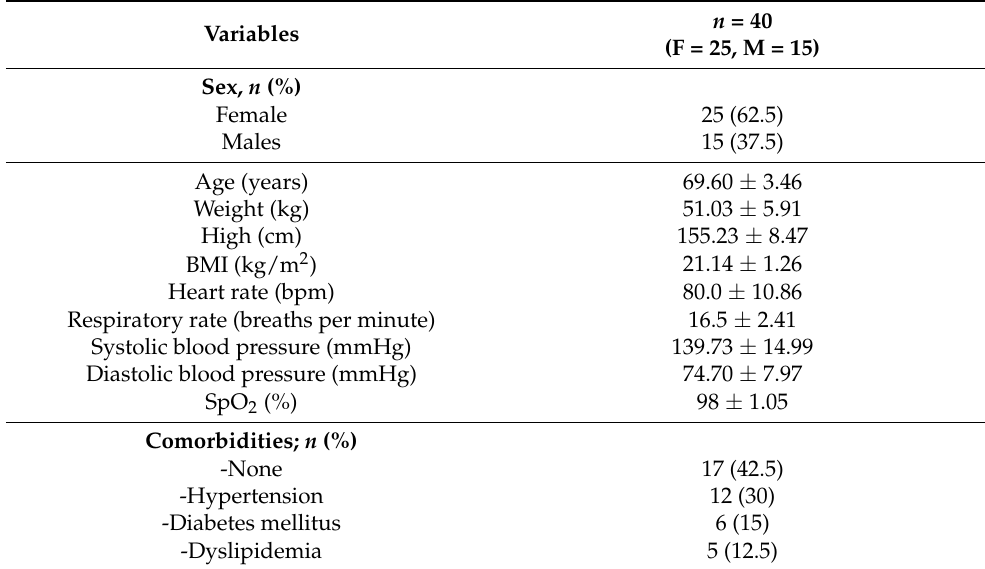
Table 1. Characteristics of the subjects. Values are means ± SD.